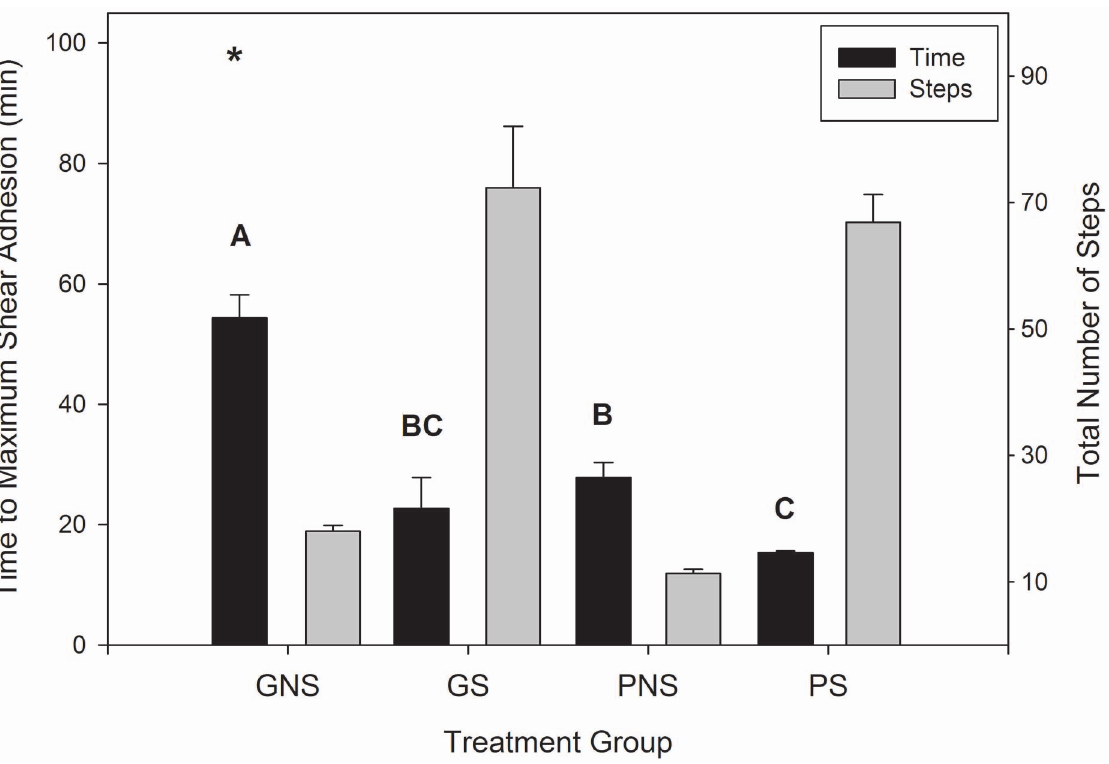
Figure 2. Time to maximum shear adhesion and total number of steps taken by Tokay geckos ( Gekkogecko ) with wet toe pads. Time to maximum shear adhesion (min) and total number of steps until maximum shear adhesion was reached for each treatment group (GNS = Glass non-stepping, GS = Glass stepping, PNS = PMMA non-stepping and PS = PMMA stepping). Bars with the same letter are statistically indistinguishable. Error is reported as mean 6 1 s.e.m. The ‘‘*’’ represents the approximated time to maximum shear adhesion (min) in the GNS